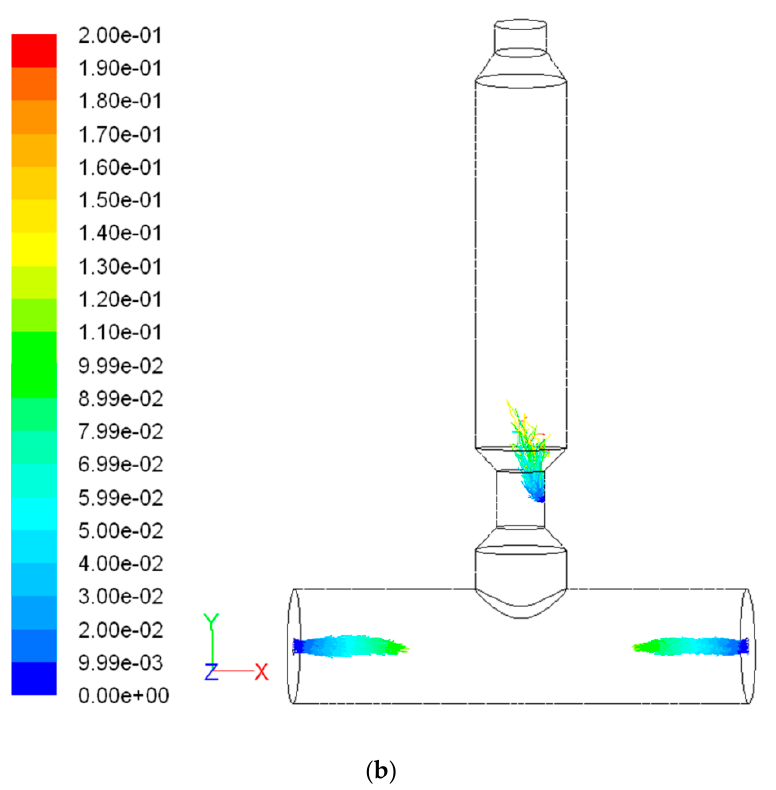
Figure 2. Comparison of particle resident time (seconds) for ( a ) E-STR model and ( b ) E-Gas model.